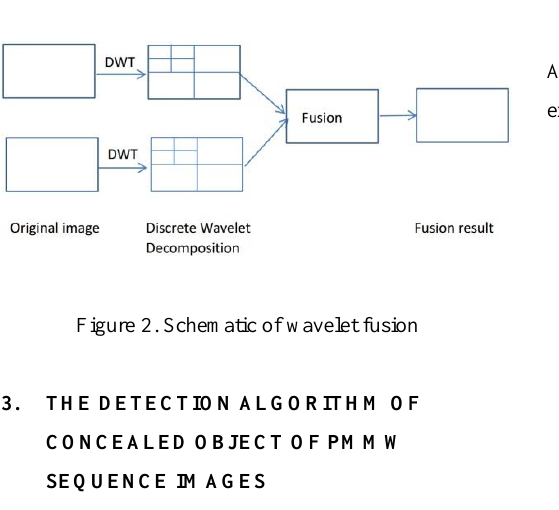
Figure 3. Flow Chart of the detection method of human-body concealed